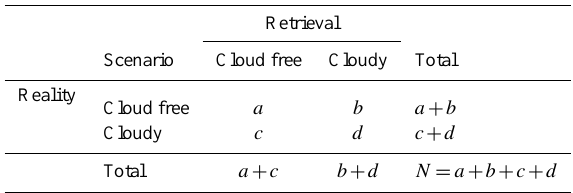
Table 3. Contingency table applied to every pixel of the simulated scene.